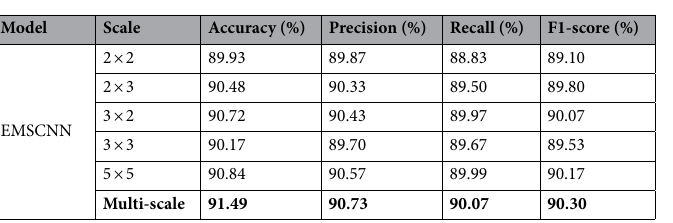
Table 7. Classification results of EMSCNN at different scales.